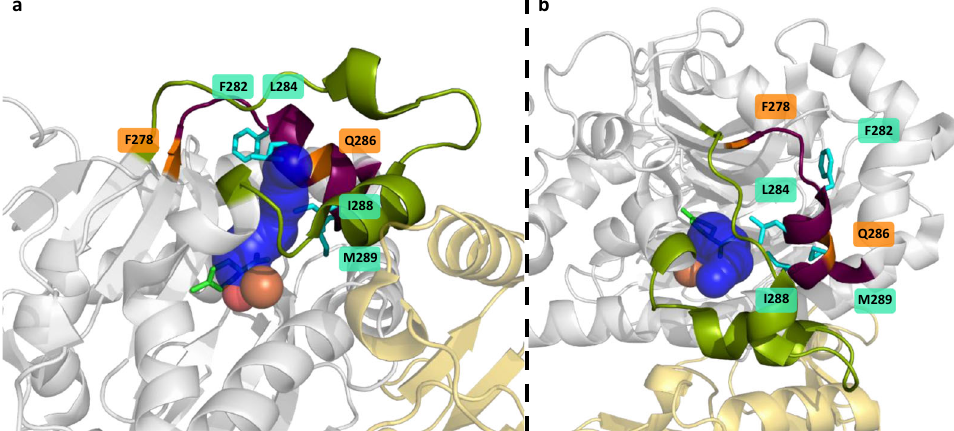
Fig. 7 Highlighted positions with in fl uence on product formation and selectivity by site mutation or insertion. Side ( a ) and top view ( b ) of the α -subunit (gray) and β -subunit (yellow) of the CDO oxygenase (PDB entry: 1WQL). Loop 1 (green cartoon), loop 2 (purple), iron (orange sphere), oxygen (red spheres), and the docked R -( + )-limonene, as well as the via CAVER calculated active site tunnel (blue, probe radius 1.2 Å, iron as starting point) are shown. The residues F282, L284, and M289, whose site mutations had a major impact on selectivity and product formation, are highlighted as cyan sticks. The LILI-based insertion sites F278 and Q286 are highlighted as orange